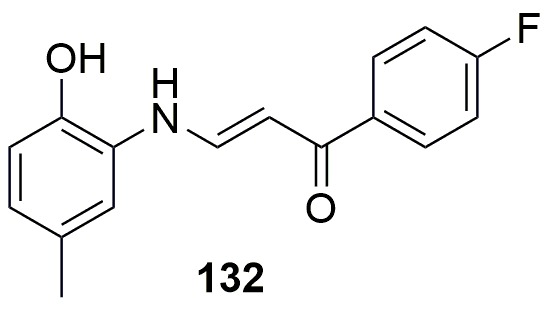
Structure of 132.